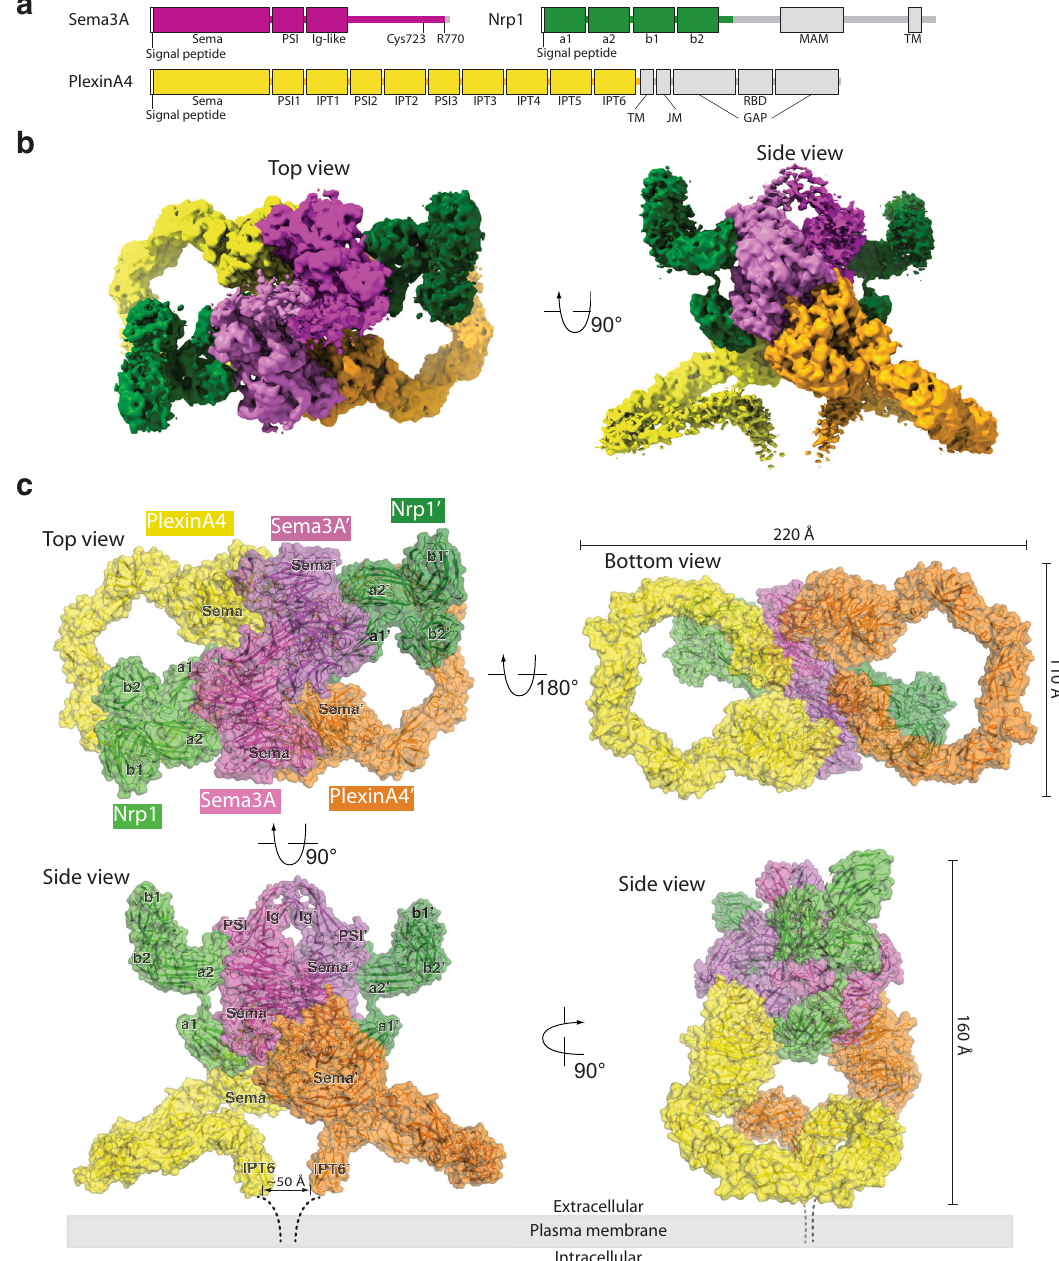
Fig. 1 Overall structure of the Sema3A/PlexinA4/Nrp1 complex. a Domain structures of mouse Sema3A, PlexinA4, and Nrp1. Colored parts indicate boundaries of constructs used in the structural analyses. b Overview of the cryo-EM map of the Sema3A/PlexinA4/Nrp1 complex. The color scheme is the same as a . c Atomic model of the Sema3A/PlexinA4/Nrp1 complex based the cryo-EM